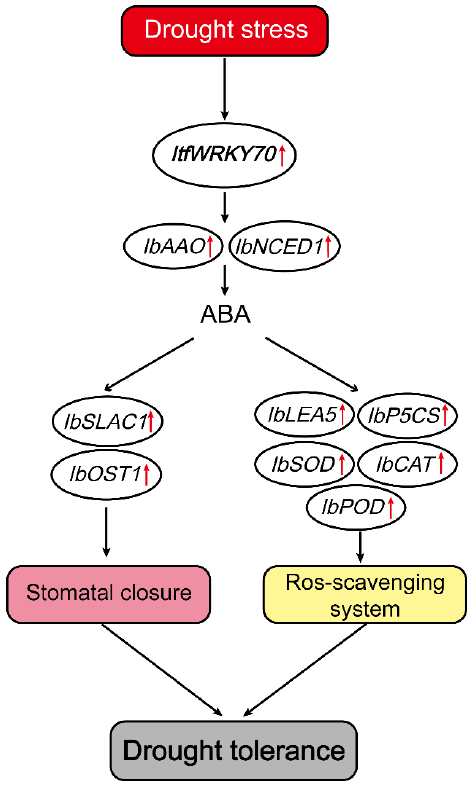
Figure 9. A proposed model for regulation of ItfWRKY70 in drought stress tolerance in transgenic sweet potato. ↑ Indicates up-regulation of genes coding these enzymes